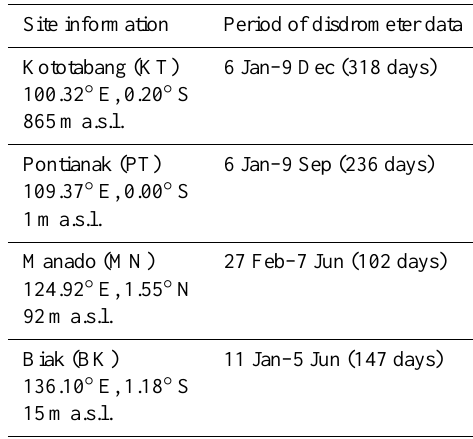
Table 1. Site parameters and observation periods during 2012 at KT, PT, MN and